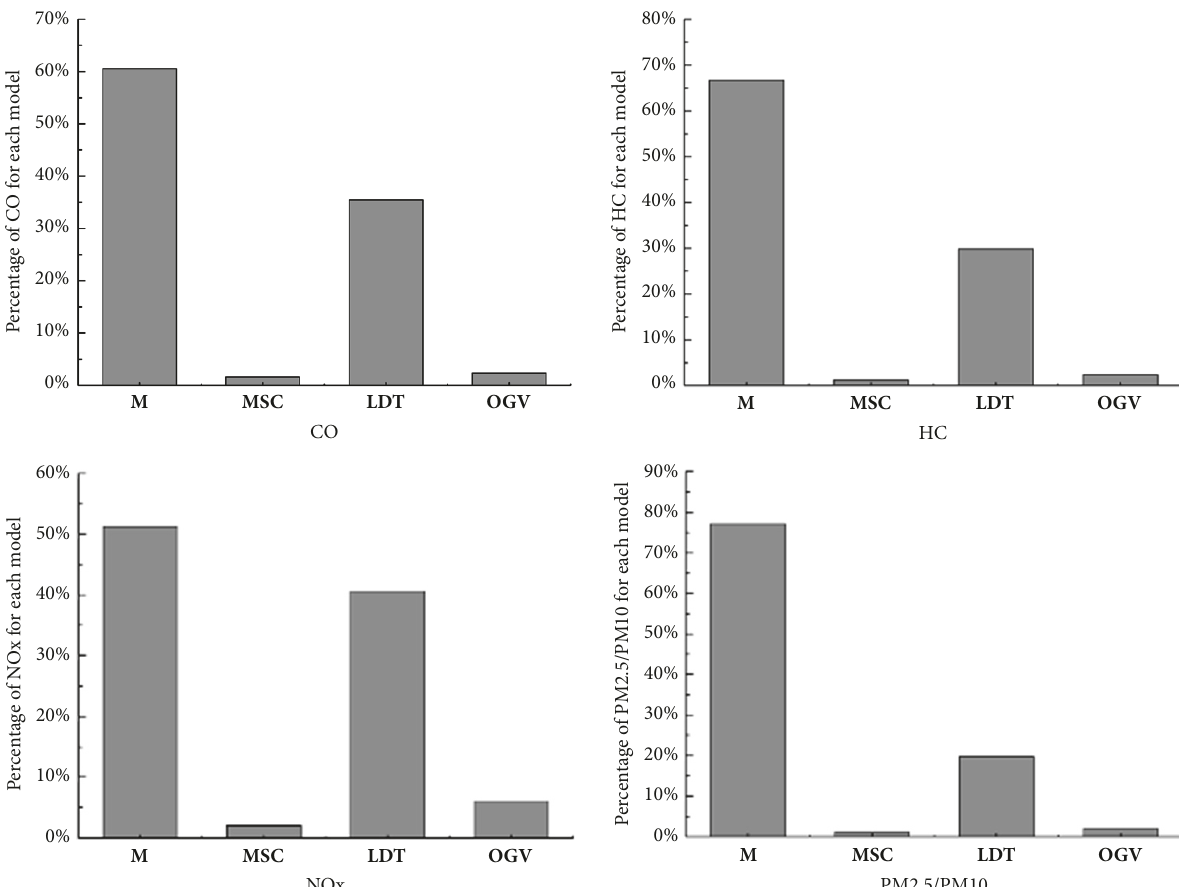
Figure 2: Emission sharing rate of each pollutant. Notes: M: minivan; MSC: middle-sized Coach; LDT: light duty truck; MDT: medium duty truck; and OGV: other gasoline